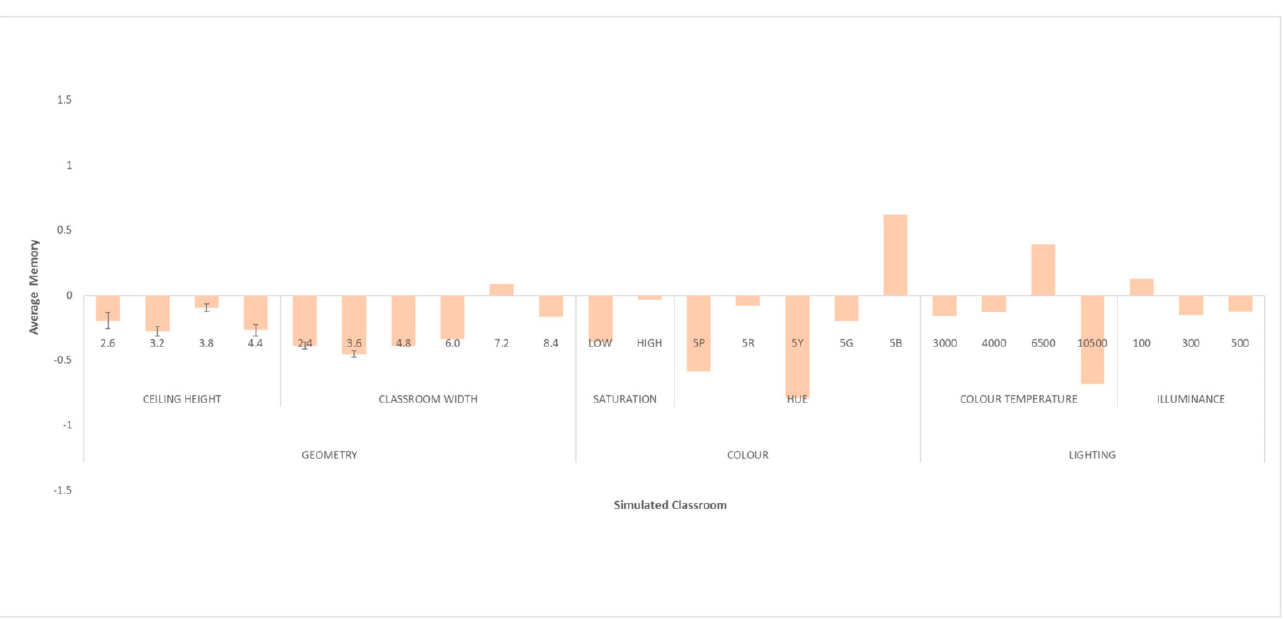
Figure 6. Standardised means of the psychological memory task for women, Memory-Correct Responses for women.